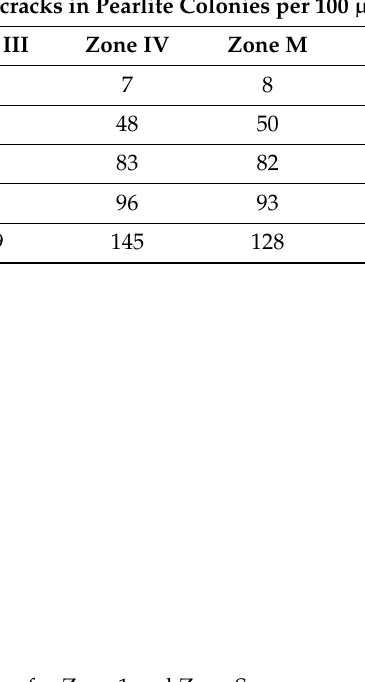
( b ) Figure 15. Microstructure of specimen in Zone I ( a ) and Zone IV ( b ) for strain level ε z 1 = 0.38 (red arrow—direction of upsetting). With a further increase in strain ( ε z 3 = 1.10), there was a change in the trend of the microstructural damage evolution and distribution. This can be seen in Figure 17. In Zone I (Figure 17a), the microcracks in the form of multiple fractures of cementite lamellae (area marked F) and the microcracks (marked G) are very noticeable. On the other hand, in Zone IV (Figure 17b), the damages generated due to the fracture of cementite lamellae are also present but the coalescence of the microcavities is not clearly visible, i.e., the level of accumulated damage is lower compared to Zone I. A similar distribution of microcracks can be detected for Zones I and IV at the limiting strain of ε z 4 = 1.59 (Figure 18).